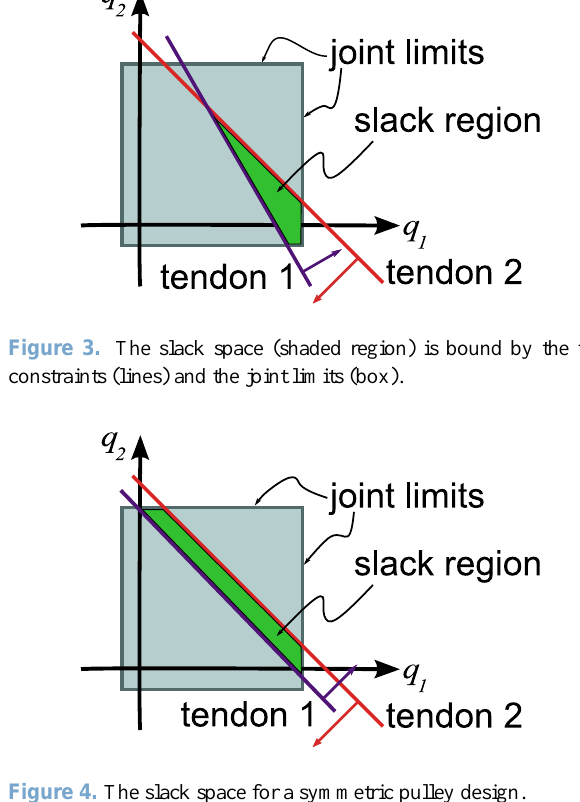
Figure 4. The slack space for a symmetric pulley